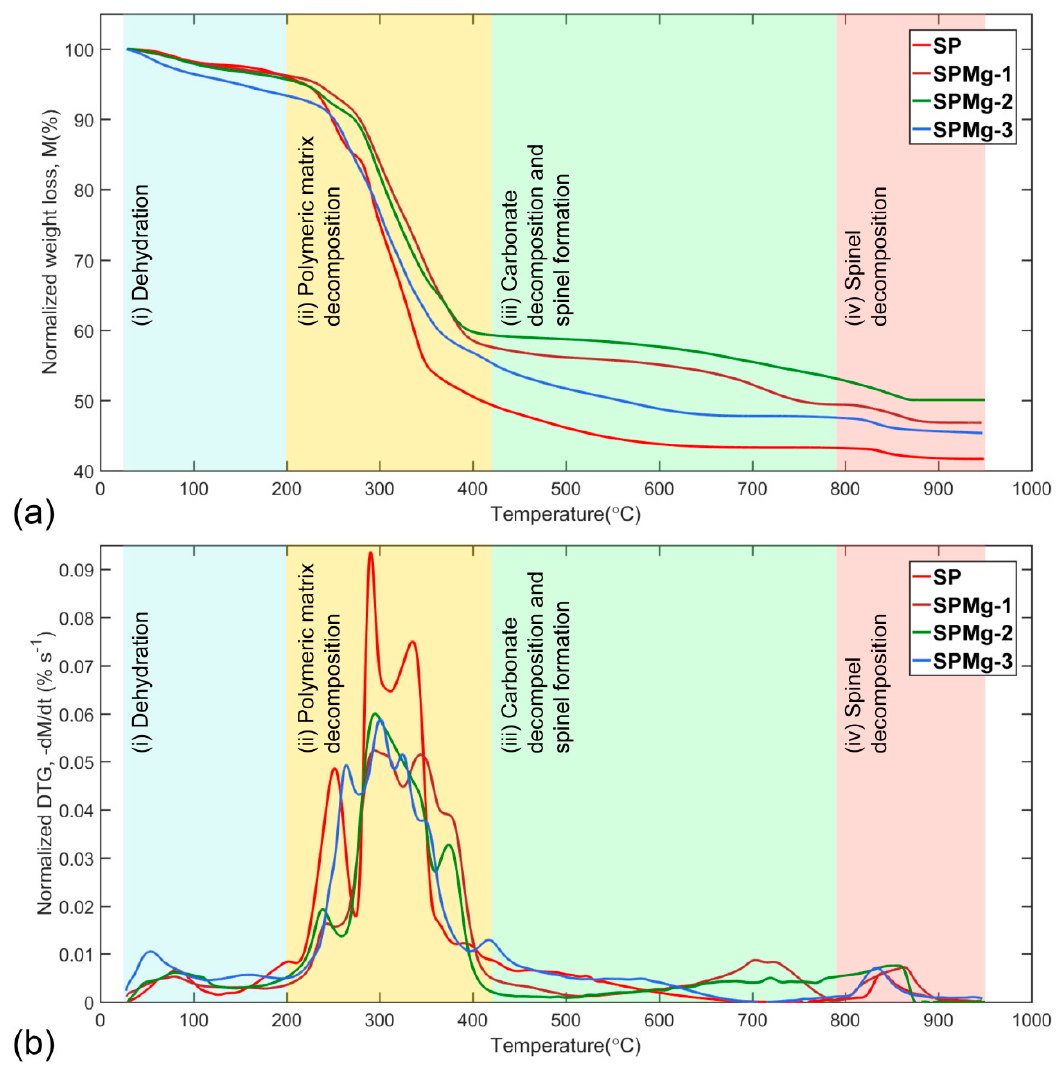
Figure 2. Normalized curves of ( a ) mass loss, M, and ( b ) DTG, as a function of temperature, of thermal decomposition of synthesis precursors divided into four zones: (1) Dehydration, (2) polymeric matrix decomposition, (3) carbonate decomposition and spinel formation, and (4) spinel decomposition.